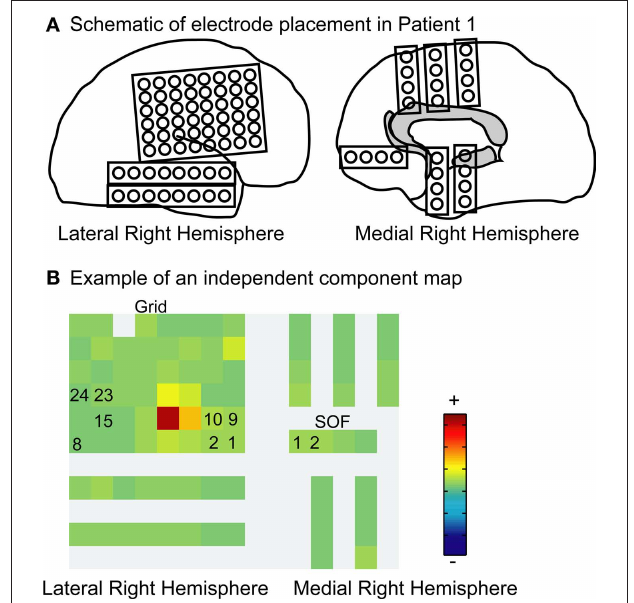
FIGurE 2 | Example independent component. (A) Schematic of electrode placement for Patient 1 (not to scale). Lateral view of right hemisphere on the left, and medial view of right hemisphere on the right. (B) Example map from one independent component. Each square represents an electrode from (A) . Electrodes referred to in later figures and text (e.g., Grid9, SOF1, etc.) are labeled here.